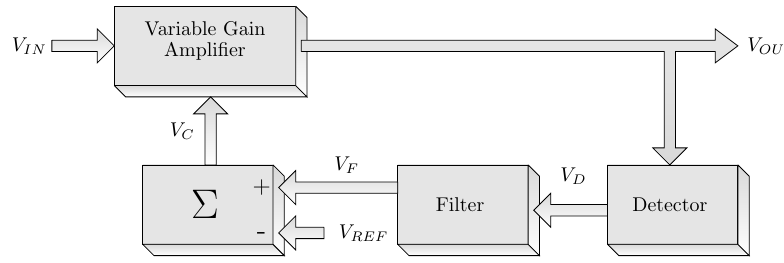
Figure 3. Analog AGC feedback configuration